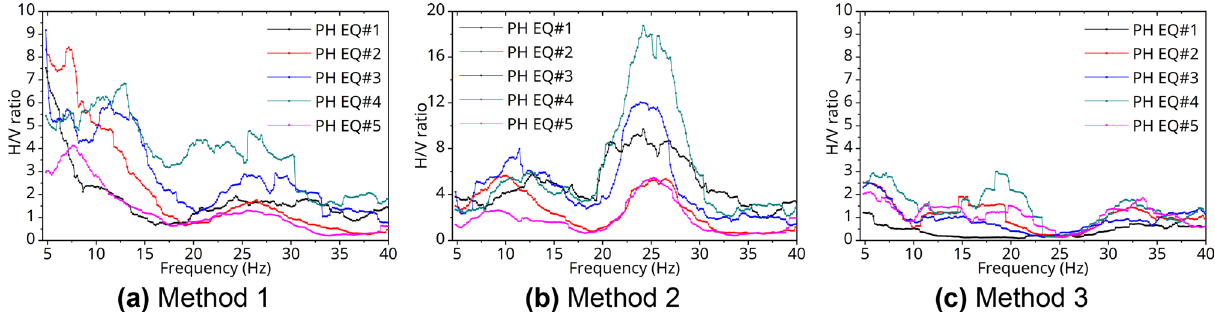
Figure 9. H/V Fourier spectra ratio with PH